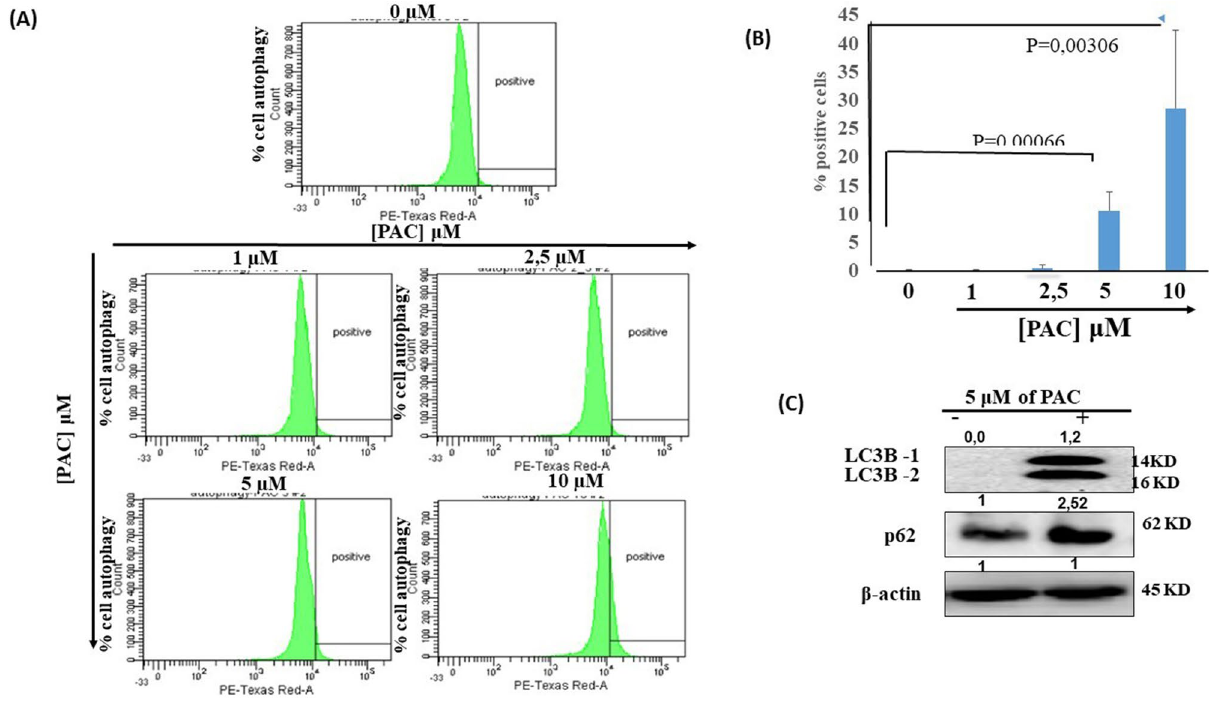
Figure 5. PAC promotes autophagy in oral cancer cells by targeting LC3B and p62 protein expression. ( A ) in vitro effect of PAC on Ca9-22 cells autophagy: Ca9-22 cells were stimulated or not with various concentrations of PAC for 24 h, then incubated with a diluted Autophagy Probe, Red at 1:50 for 1 h in the dark. Stained cells were afterwards analyzed by flow cytometry, (n = 3). ( B ) Statistics analysis of fold changes in % of staining autophagy cells between ca9-22 treated by PAC concentration and Ca9-22 untreated cells (t = test, p < 0.005; n = 3). (C) Western Blot showing an overexpression at protein levels of two autophagy markers (LC3B and p62) in Ca9-22 cells treated by 5 µM of PAC (n = 3). All Blots for each autophagy protein derive from the same experiment and were exposed at same time of phosphor imager